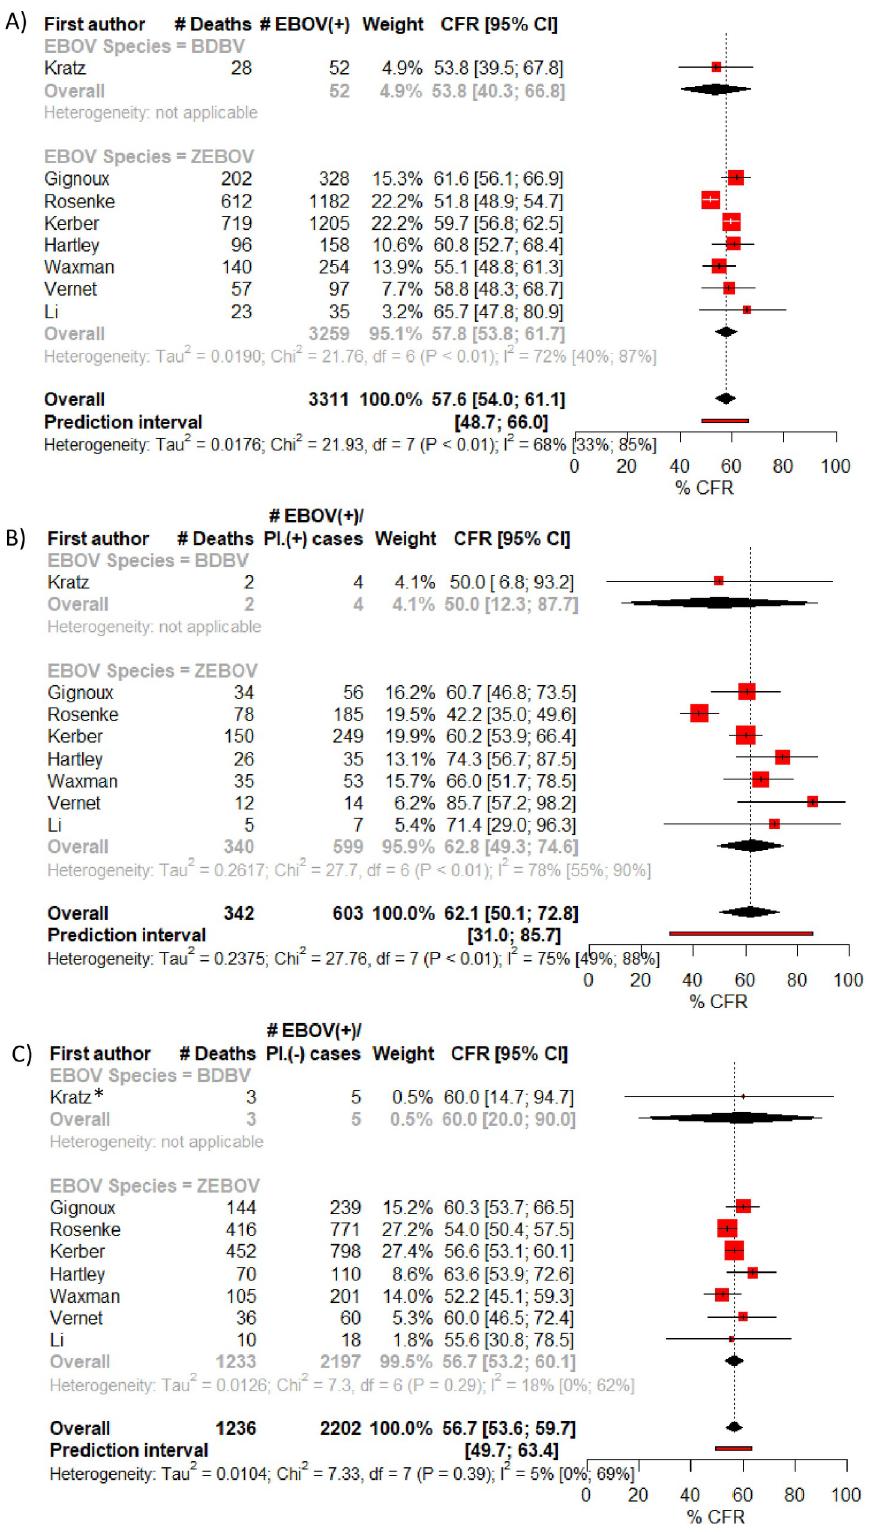
Fig 3. Meta-analysis of CFR: A) crude CFR, B) CFR of EBOV(+)/Pl/(+) cases, C) CFR of EBOV(+)/Pl.(-) cases.